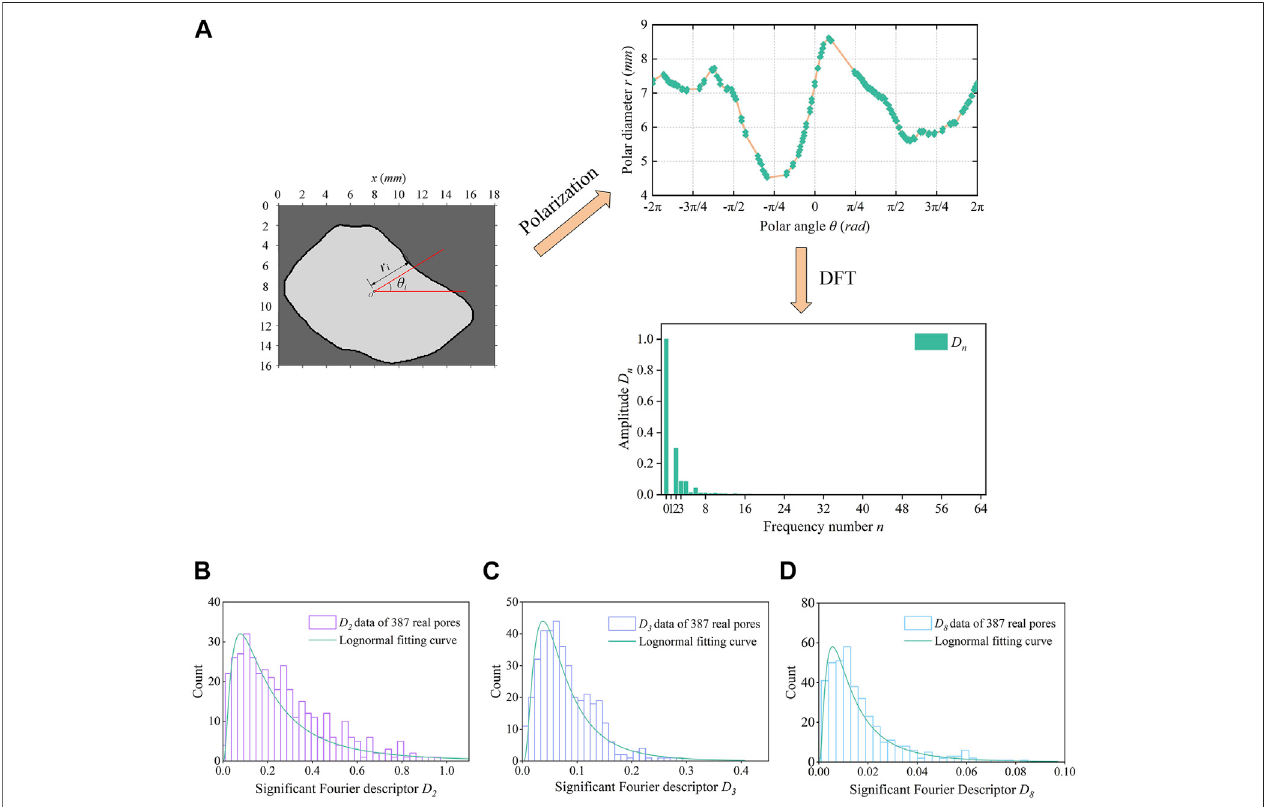
FIGURE4| Analysisforextracted natural pores: (A) processofpolarizationand DFTforanatural poreexample; (B) – (D) thestatisticalresults ofFourierdescriptors D 2 , D 3 , and D 8 , respectively, from 387 extracted pores.